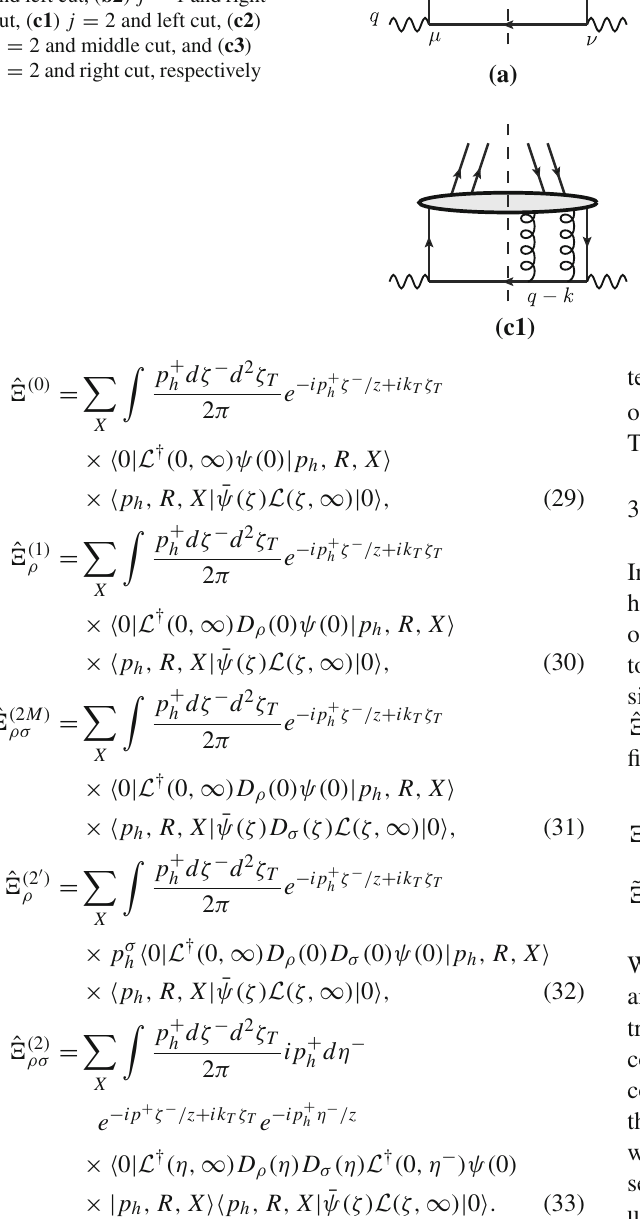
Fig. 3 The first few diagrams as examples of the considered diagram series with exchange of j -gluon(s) and different